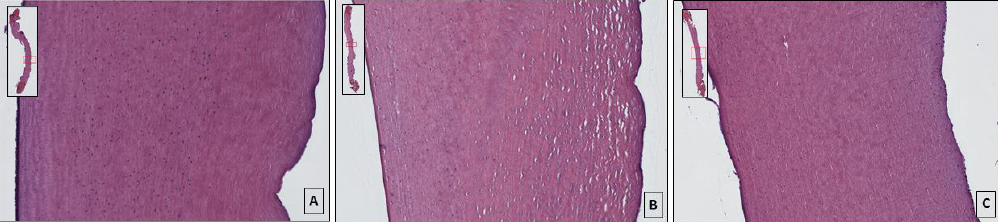
Figure 5. Corneal section images after Hematoxylin & Eosin histological staining; ( A ) healthy cornea slide, note normal appearance of corneas’ thickness and the stroma show compact collagen lamellae; ( B ) injured cornea showing the alteration in the structure of the stroma, the lamellas of collagen fibers appeared disorganized with the presence numerous fissures; ( C ) details of the riboflavin / UV-A corneal phototherapy treated cornea, showing a more compact collagen lamellae respect to injured corneas. The fissures between the lamellae appear reduced. The stroma located on the right of the corneal section represents the anterior part of the cornea; the left part represents the inner (posterior) stroma of the cornea.